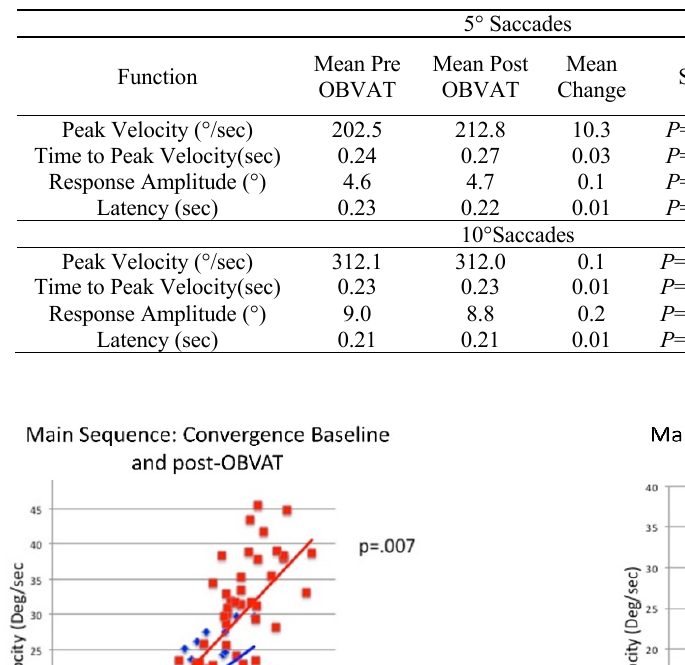
Table 4: Comparison of Objective Measures of Saccades Pre- and Post-OBVAT